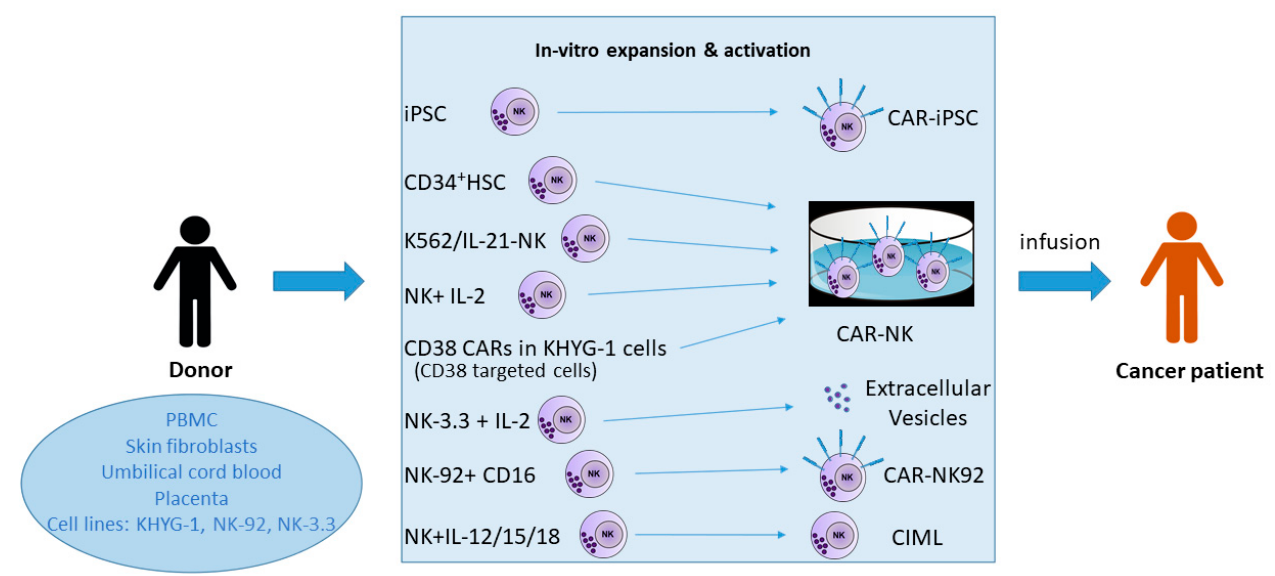
Figure 1. NK cells based cancer immunotherapies. Abbreviations: PBMC: peripheral blood mononuclear cells; iPSC: induced pluripotent stem cells; HSC: hematopoietic stem cells; CAR-NK: chimeric antigen receptor natural killer cell; CAR: chimeric antigen receptor; CIML: cytokine- induced memory-like NK cells.